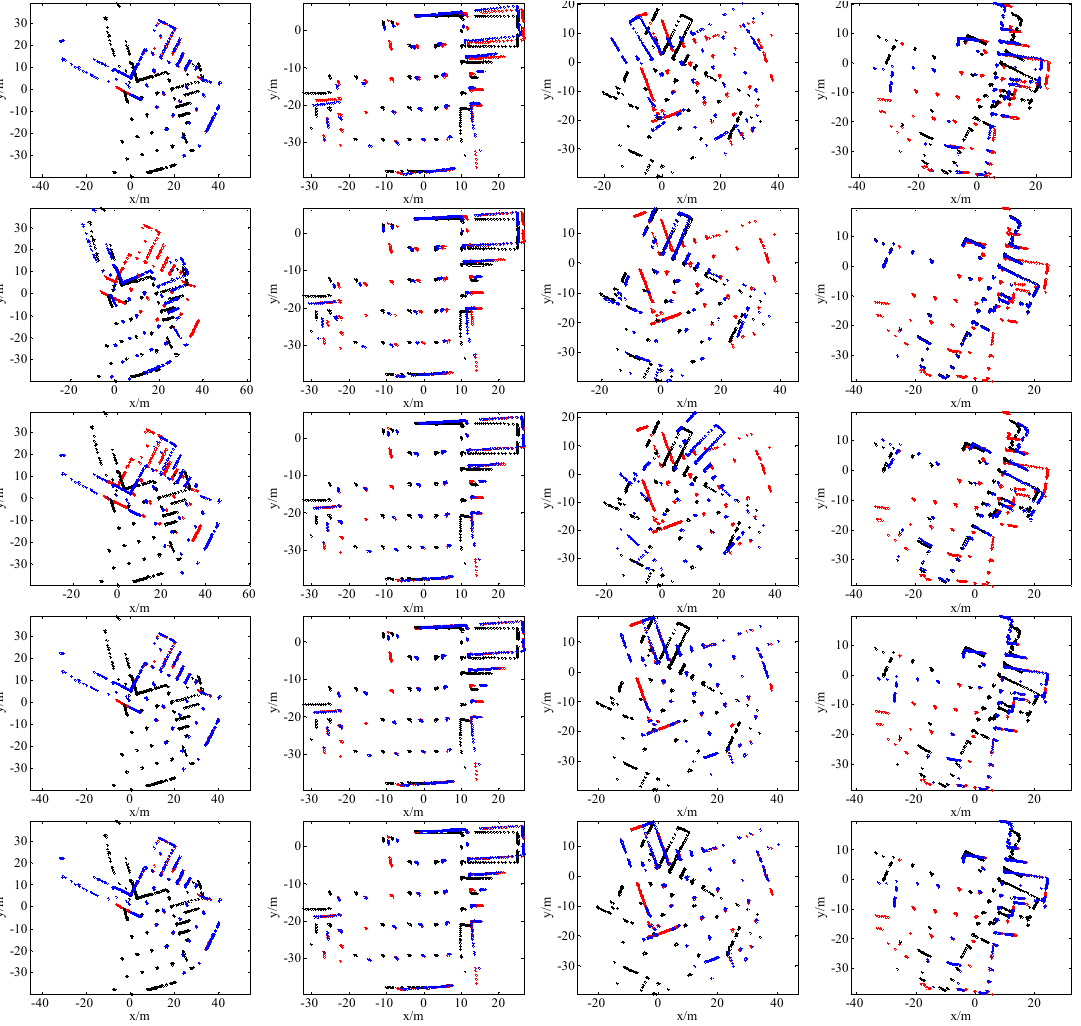
Figure 7. Some scan matching results of dataset 1. The first row is the results of PSM; the second row is the results of PLICP; the third row is the results of ICP without an initial guess (ICP 1 ); the fourth row is our scan matching results; the last row is the results of ICP with a good initial guess (ICP 2 ). In all of these plots, the points denoted by red +, black +, and blue + represent the first laser scan S k -1 , the second laser scan S k , and the transformed laser scan of S k by using the estimated transformation matrix, respectively.